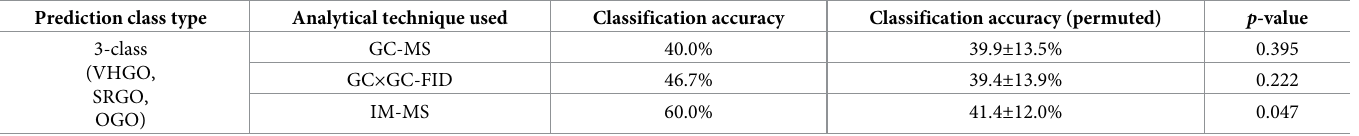
Table 4. Classification accuracy of Petroleum UVCB